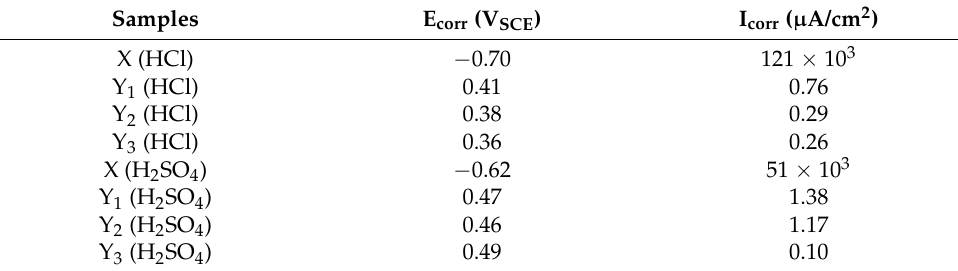
Table 2. The E corr and I corr values determined from Tafel slopes.